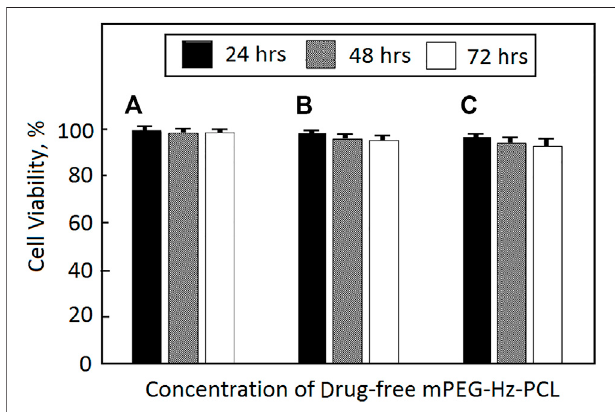
FIGURE3| CytotoxicityofSW1353cellsagainstdrug-freemPEG-Hz- b - PCL nano-micelle determined by MTT assay (* p < 0.05) at